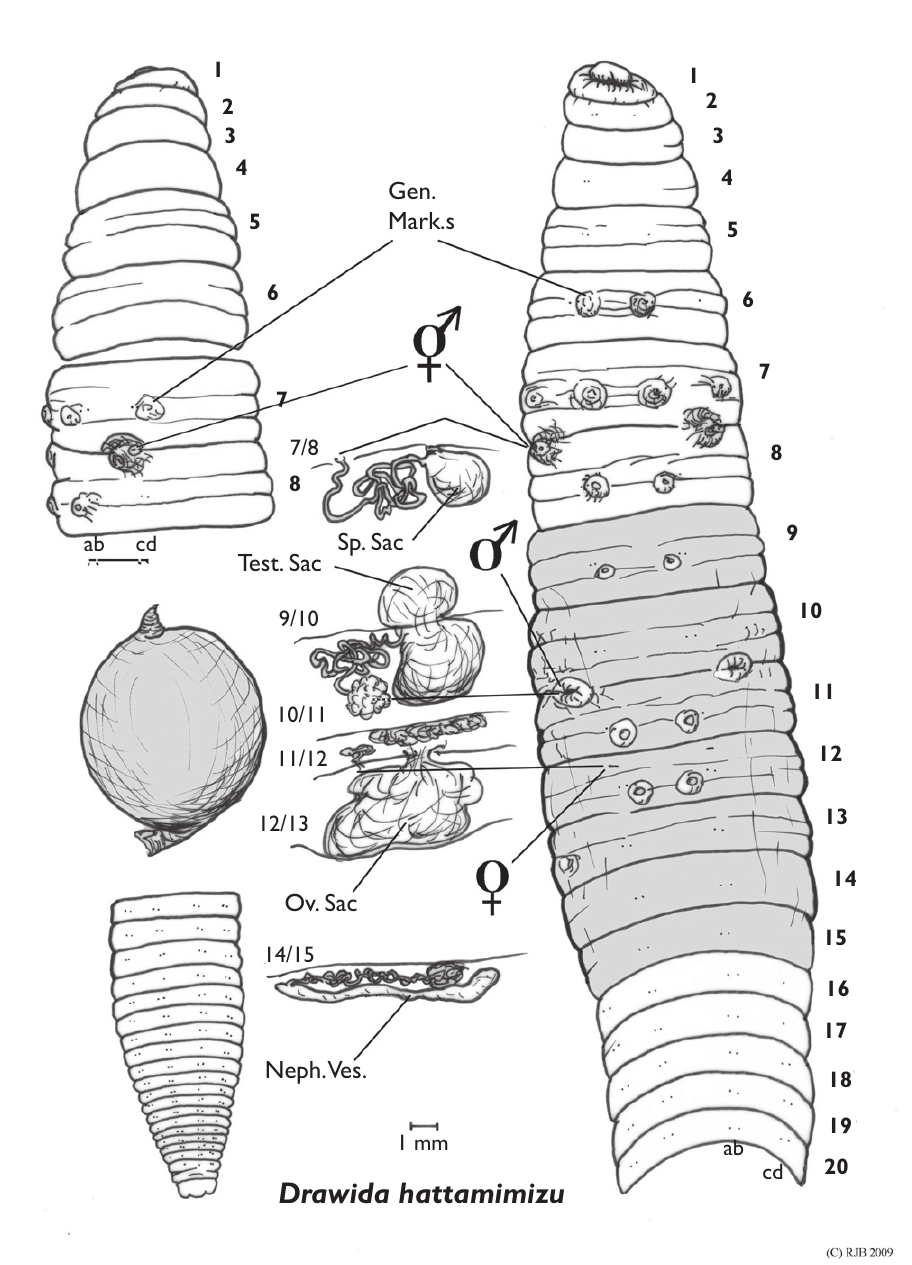
Figure 1. Drawida hattamimizu , Neotype showing dorsal view of anterior (prolobous prostomium and no dorsal pores); a rotated dorsolateral view showing spermathecal pores in 7/8; a cocoon (shaded); ventral view of posterior; spermathecae in 8, male organs in 9–10; female organs in 11–12; a nephridium in 15; and details of anterior ventrum with segments numbered and pores labeled. Th e clitellum is shaded to its fullest extent (in life the whole body is dark coloured with the clitellum only slightly